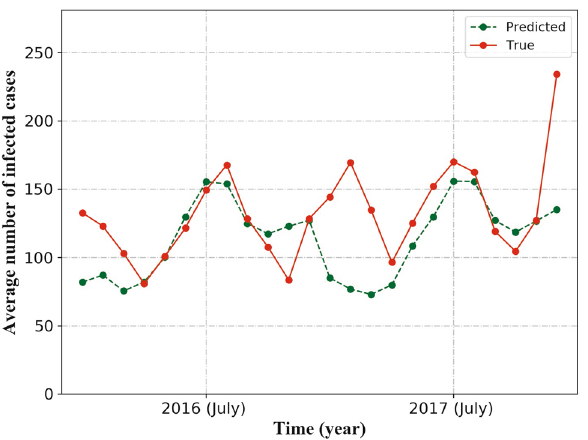
Figure 7. The comparison between average number of cases in the predicted data and the counterparts in the true data. The red line stands for true value while the green line stands for predicted value. (See Supplementary Table 6 in Supplementary material to obtain the detailed data).